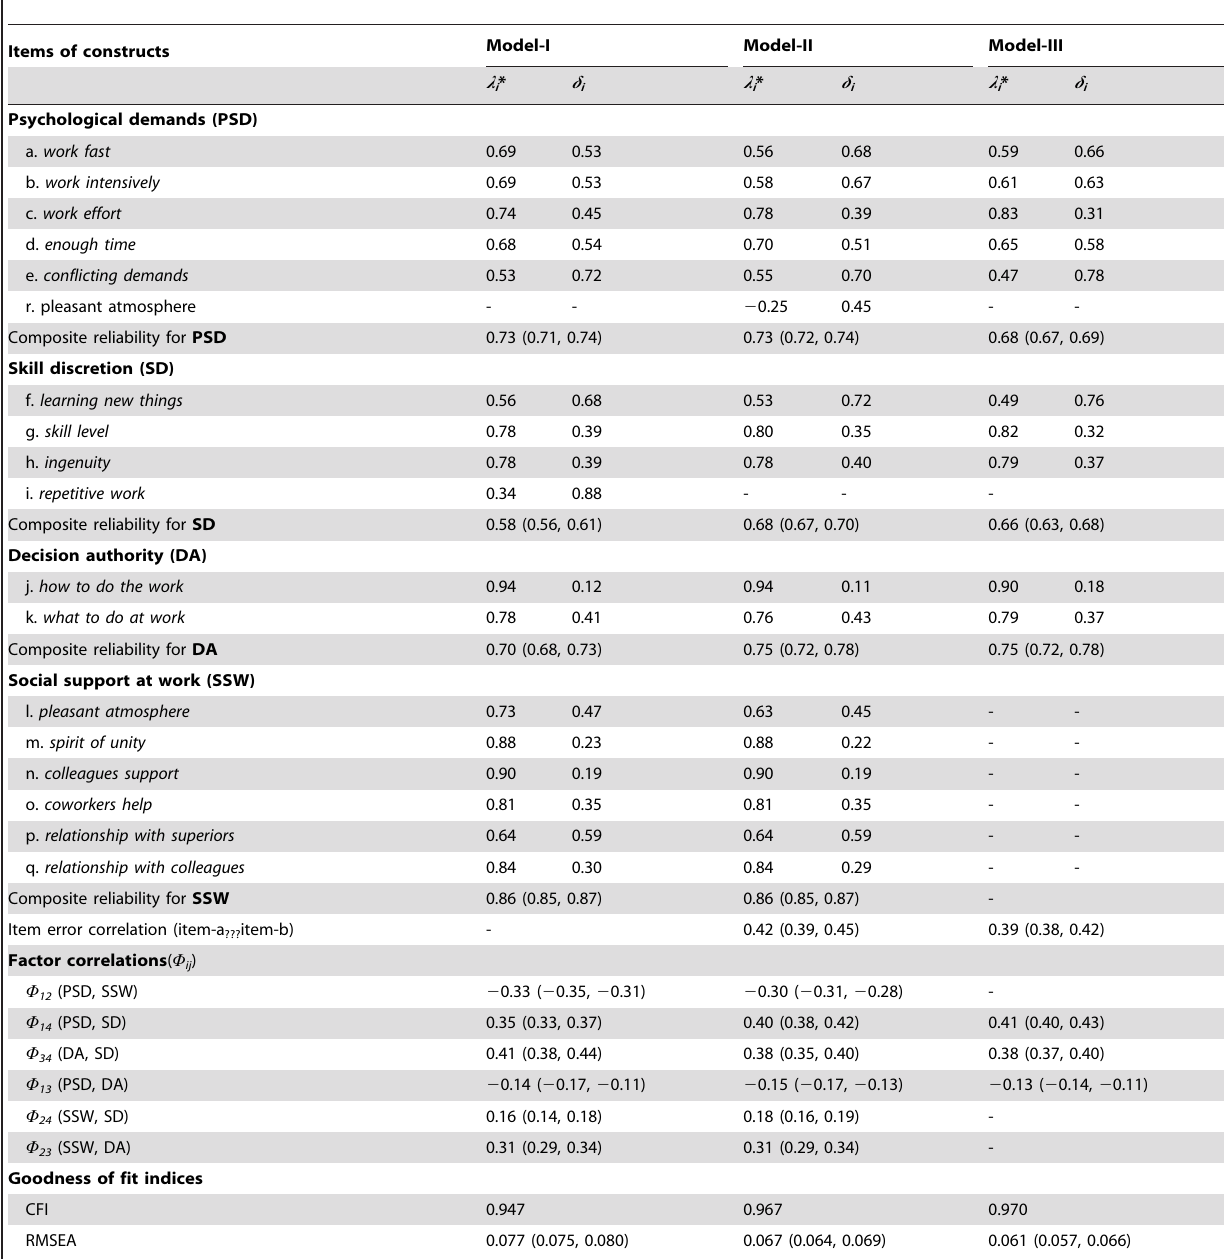
Table 2. Standardized loadings ( l i ), measurement errors ( d i ), factor correlations ( W ij ), composite reliability ( r cr ) and fit indices